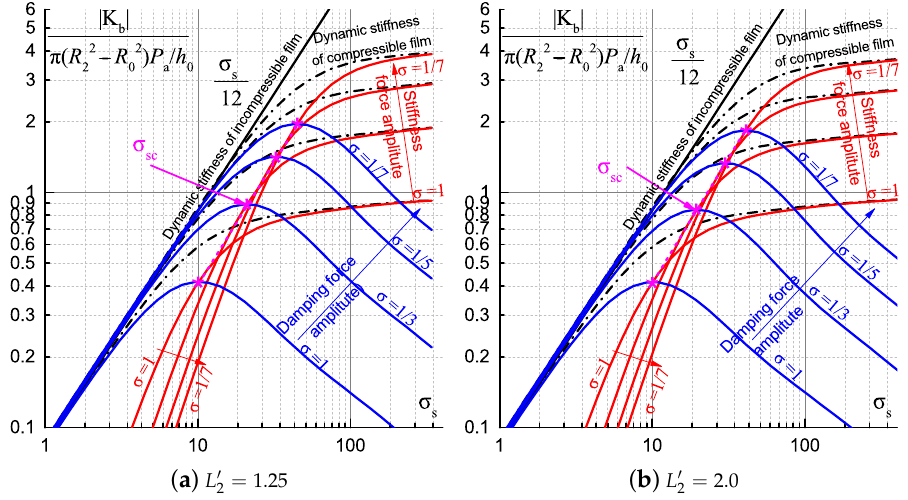
Figure 17. Dynamic stiffness modulus of the 1D ring with supply pressure under different radius ratios (flows from inside).